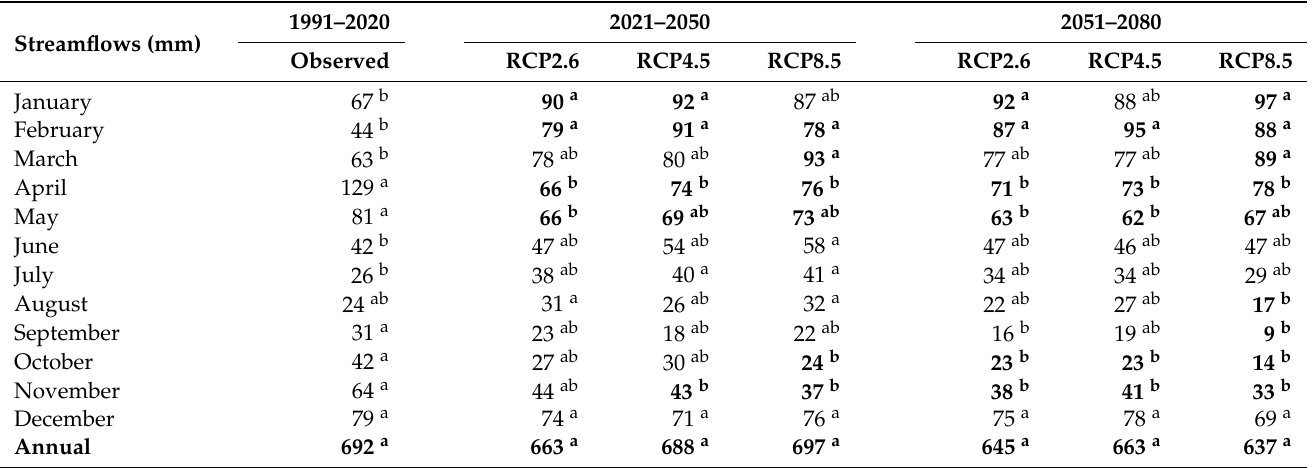
Table 6. Average streamflows (mm) observed in the eastern zone (at St. Margaret’s of the Bear River watershed) during the 2000s and modeled future projections during the 2030s and